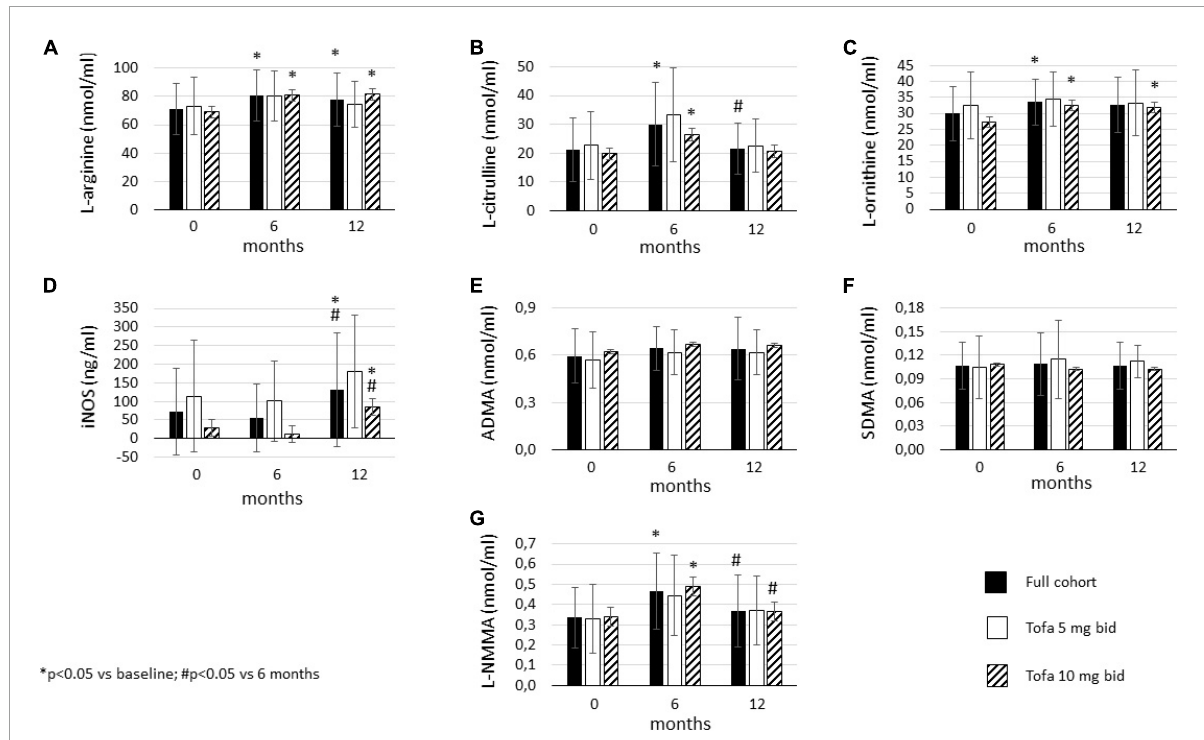
FIGURE4 Effects of one-year tofacitinib therapy on metabolites in the urea cycle. (A) L-arginine levels increased in the full cohort and in the 10 mg bid subset after 6 and 12 months. (B) L-citrulline production transiently increased in the full cohort and the 10 mg bid subset after 6 months. (C) L-ornithine levels increased overtime in the full cohort and in the 10 mg bid subset after 6 and 12 months. (D) iNOS release increased in the full cohort and in the 10 mg bid subset after 12 months. (E) ADMA and (F) SDMA levels did not change overtime. (G) L-NMMA production transiently increased in the full cohort and the 10 mg bid subset after 6